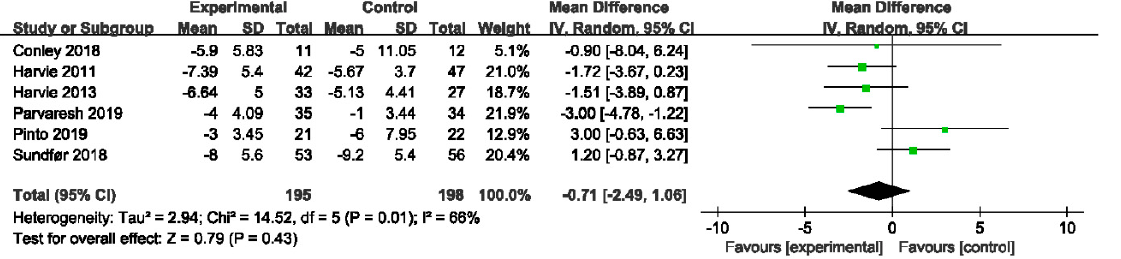
Figure 5. Forest plot for waist circumference in trials that compared IER with CER. Abbreviations: CI, confidence interval; IER, intermittent energy restriction; CER, continuous energy restriction. The unit of mean difference in waist circumference is cm.